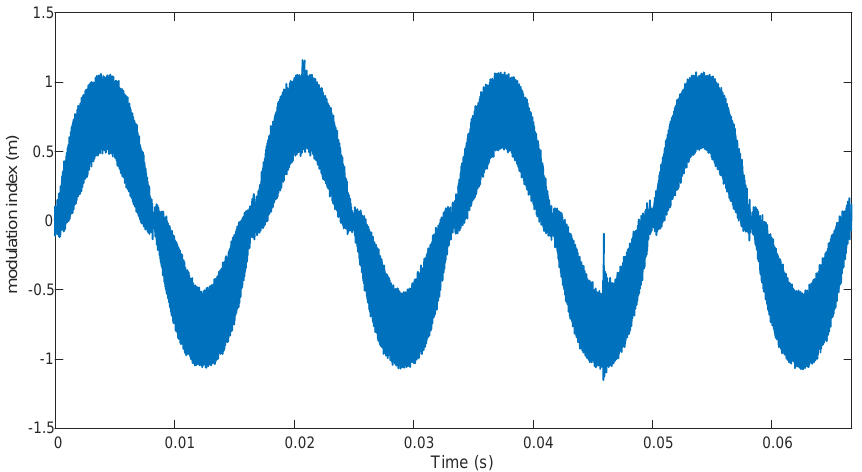
Figure 18. Control action 𝑢 𝑠𝑚𝑐 for reference 𝑖 2∗ with SMC plus P + R .